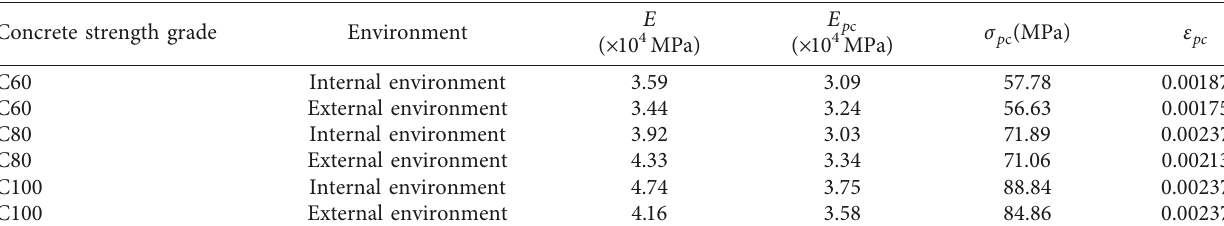
Figure 8: Comparison of test curves and curve from formula of C100 concrete. (a) Internal environment. (b) External environment. Table 3: Every parameter value in the stress-strain curve of concrete (test curve). Concrete strength